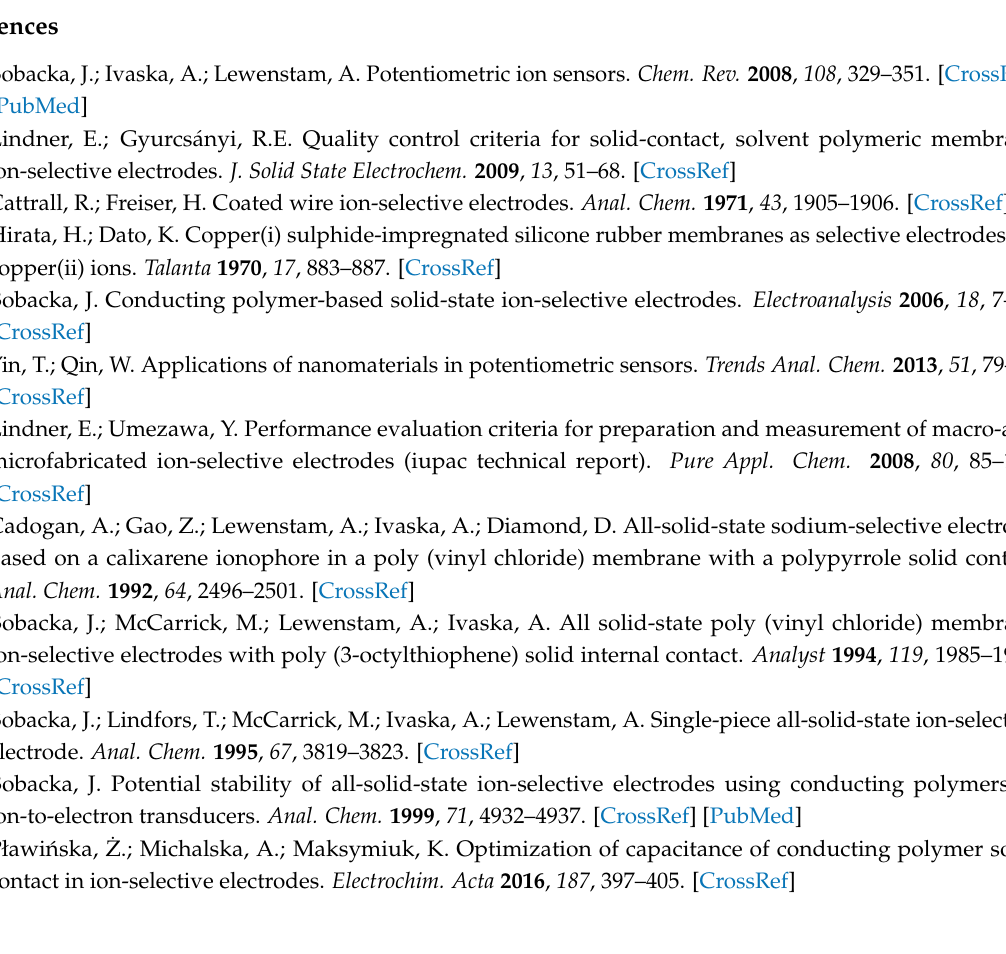
s1. Figure S1: Current response as a function of scan rate; Table S1: Comparative representation of the analytical parameters for all-solid-state ion-selective